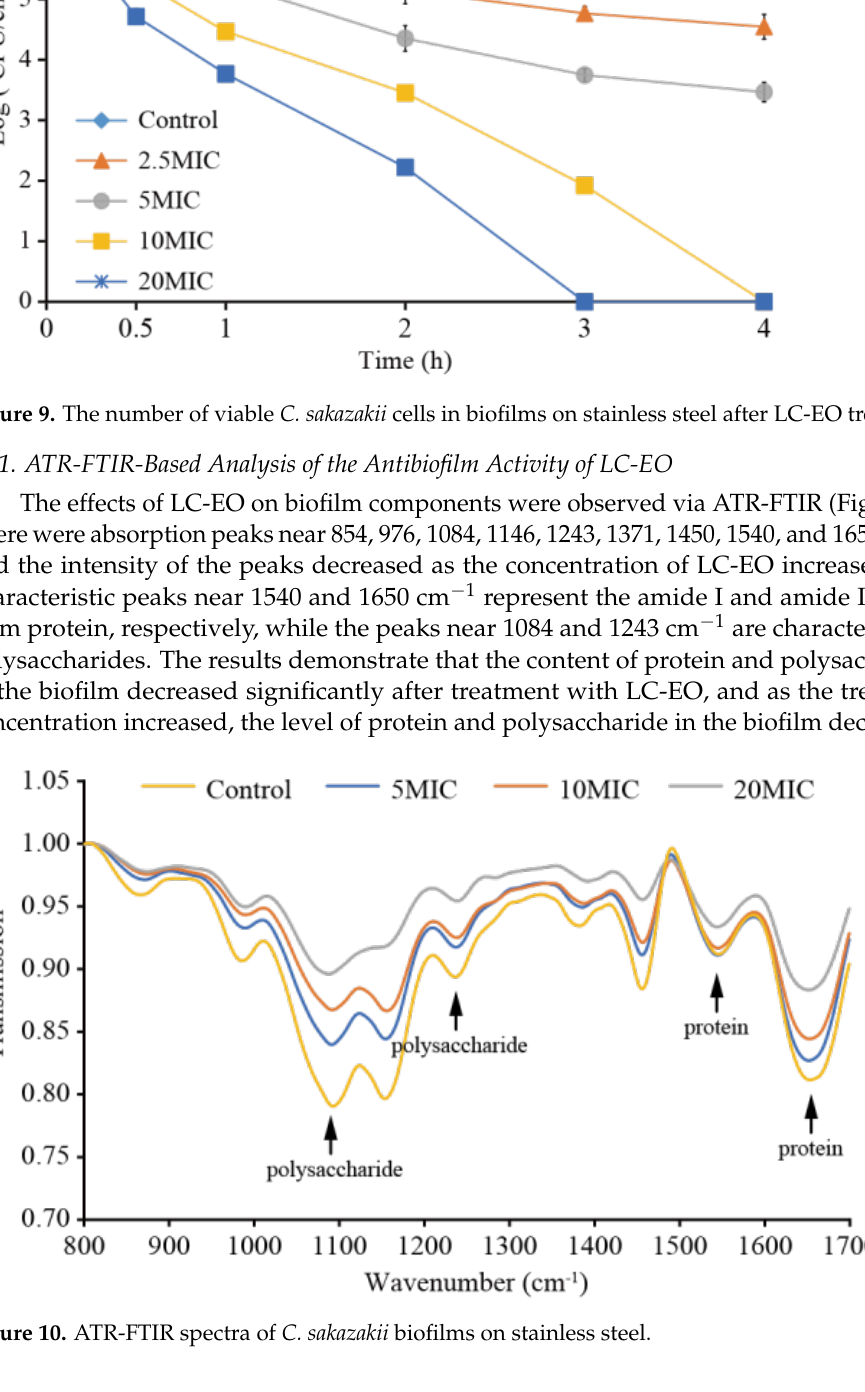
Figure 10. ATR-FTIR spectra of C. sakazakii biofilms on stainless steel. 3.12. CLSM-Based Analysis of the Antibiofilm Activity of LC-EO CLSM was employed to visualize the anti- C. sakazakii biofilm effects of LC-EO (Fig- ure 11). Untreated biofilms (Figure 11A – C) showed dense green and blue fluorescence, indicating intensely distributed biofilm architectures. With the increase in LC-EO concen- tration from 0 to 20MIC, the green and blue fluorescence decreased remarkably (Figure